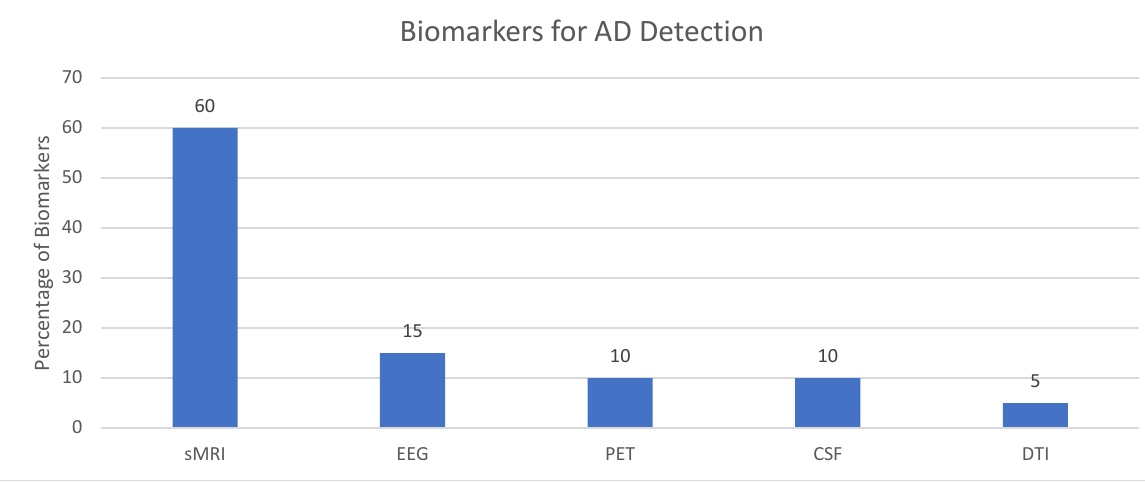
Figure 3. Description of most commonly used biomarkers for detecting AD.